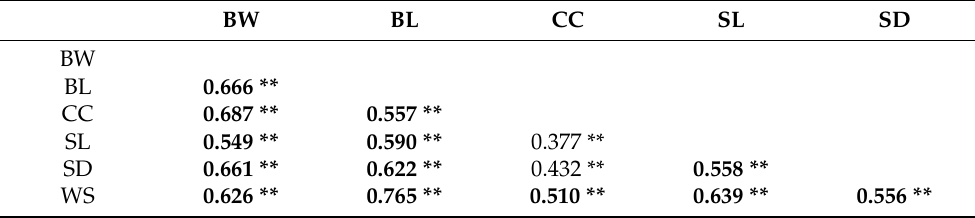
Table 5. Pearson’s Correlations between the zoometric measures and body weight for all birds.